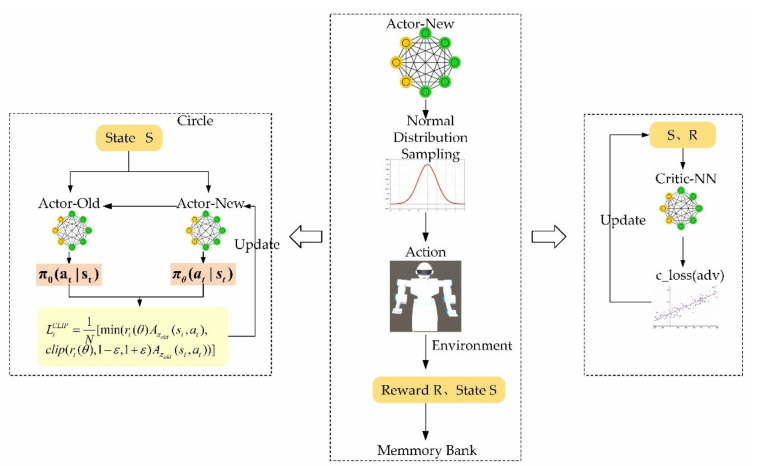
Figure 10. PPO algorithm network training